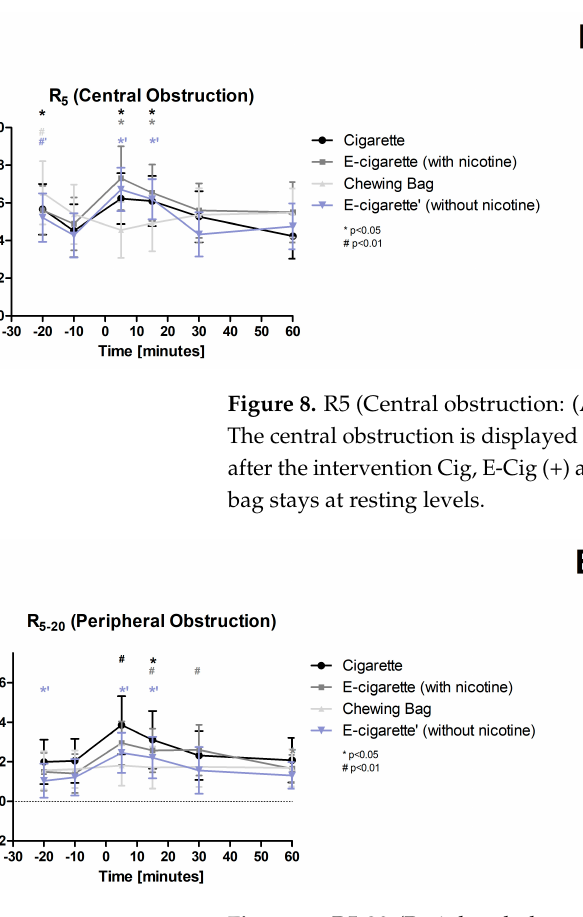
Figure 9. R5-20 (Peripheral obstruction: ( A ) total follow-up; ( B ) follow-up of expected nicotine half-life). In these figures, the peripheral obstruction is plotted against the time. After the intervention (time 5), Cig (highly significant # p < 0.01) and E-Cig (-) (significant * p < 0.05) showed an immediate increase. After 15 min, Cig and E-Cig (-) were significantly (* p < 0.05) and E-Cig (+) highly signifi- cantly (# p < 0.01) elevated. E-Cig (+) stays highly significantly elevated at 30 min. The Chewing bag does not show changes in values after the